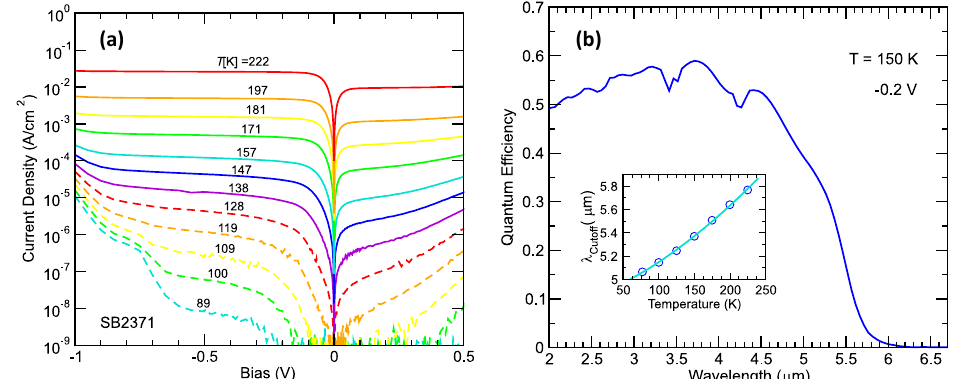
Figure 2. ( a ) Dark current density–voltage characteristics for an InAs/InAsSb type-II strained-layer superlattice nBn detector taken at temperatures ranging from 89 to 222 K. ( b ) Back-side illuminated spectral quantum efficiency (QE) for the same detector without anti-reflection coating, taken under a − 0.2 V bias at 150 K. The inset shows the 50% peak QE cutoff wavelength as a function of temperature.